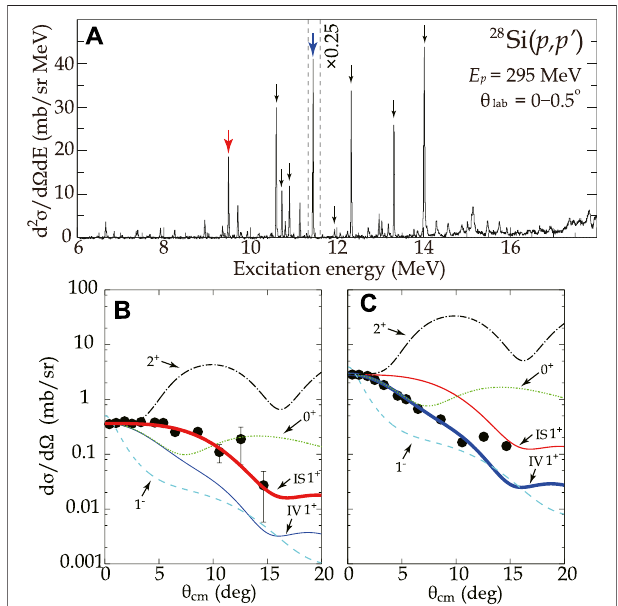
FIGURE 1 | (A) Excitation energy spectrum of the 28 Si( p , p ’ ) reaction at E p (cid:1) 295 MeV and θ lab (cid:1) 0 + − 0 . 5 + . The arrows in the fi gure indicate conditions that are de fi nitely determined as 1 + . Angular distributions of (B) IS and (C) IV spin-M1 excitations marked by red and blue arrows in (A) , respectively, in comparison with theoretical angular distributions for several multipolarities. The fi gures were taken from Matsubara et al.